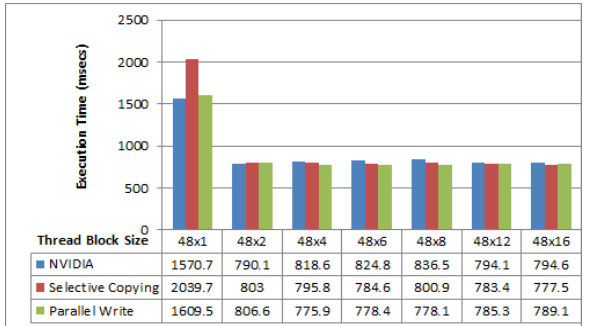
Figure 6: Exec. time for the three implementations with Tile Size = 48 x